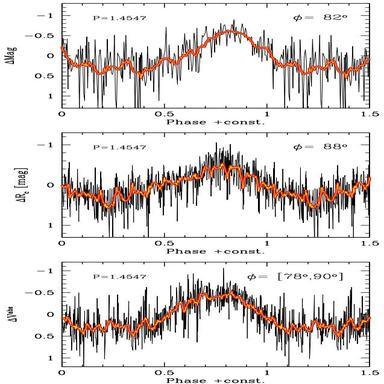
The WT1190F lightcurve by phasing observations with the short ''flashing" period of Eq. The three different datasets of Loiano (mid panel) and DeSS (TRACKER telescope; lower panel) are displayed, for comparison. For a better reading, the raw data distribution is smoothed with a 15-point running average (thick solid line). The geometrical circumstance of the orbital phase angle / spanned by the observations is reported top right in each panel.